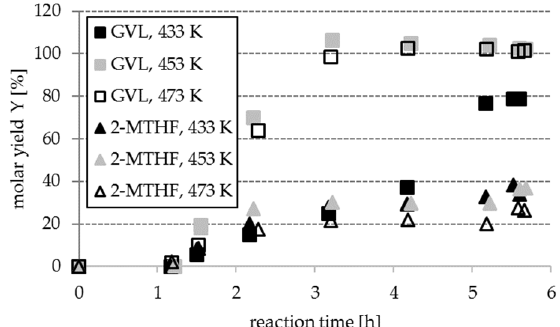
Figure 5. Molar yields of γ -valerolactone (GVL) and 2-methyltetrahydrofuran (MTHF) as a function of reaction time during the reaction of levulinic acid (LA), vanillin (V), FA, and furfural (FF) in presence of an Ru / AC catalyst and hydrogen (x cat. = 1% w / w in reactant solution, T = 433–473 K, c FF = 5 g L −1 , c LA = 20 g L −1 , c FA = 25 g L −1 , c V = 7.5 g L −1 , p = 3.4 MPa).